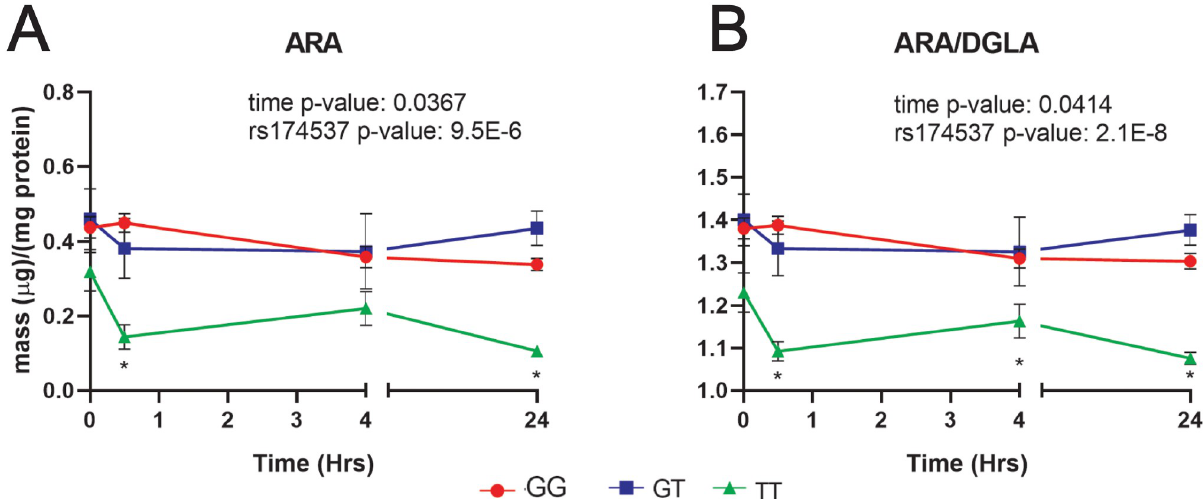
Fig 6. Genotype at rs174537 is strongly associated with cellular ARA levels and ARA/DGLA ratio in 3D cultured hepatocytes. Effect of genotype at rs174537 on cellular n-6 PUFAs over time was assess using a linear regression model. Mean ± SEM are displayed. Red circles denote GG genotype (n = 14), blue squares signify the GT (n = 6), and green triangles mark TT genotypes at rs174537 (n = 4). A) TT individuals had lower levels of cellular ARA compared to the G -allele counterparts at 30 minutes and 24 hours regardless of diet exposure (p = 0.003, p = 0.0002, respectively), which translated to significant differences in ARA/DGLA ratio (B), Individuals with the genotype TT at rs174537 had significantly lower ARA/DGLA levels at all time points (p = 0.0009, p = 0.0247, p = 8.5E-5, respectively). No statistically significant SNP-diet interactions were observed, potentially due to the relatively low dose of LA in the